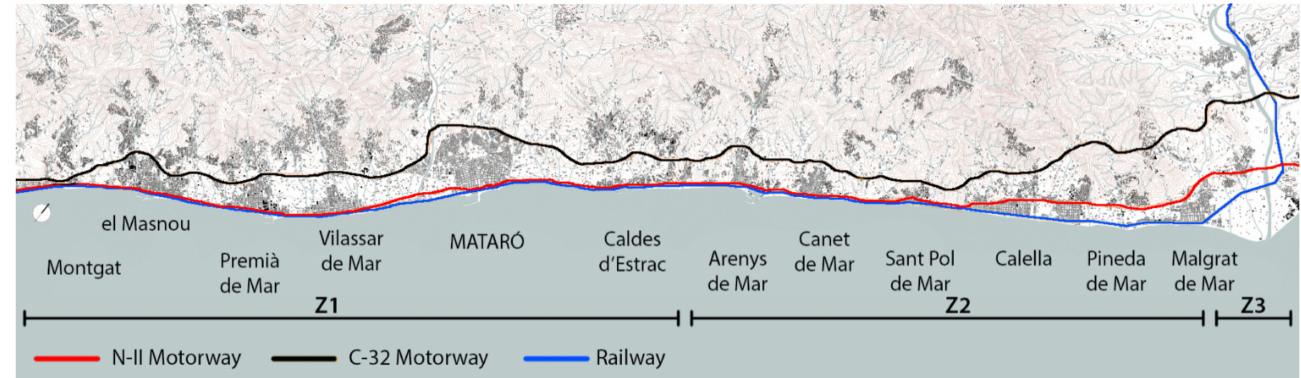
Figure 2. Transport infrastructures follow the coastline of Maresme and relate three landscape units: Baix Maresme (Z1), Alt Maresme (Z2) and Baixa Tordera (Z3) (Source: authors’ own).